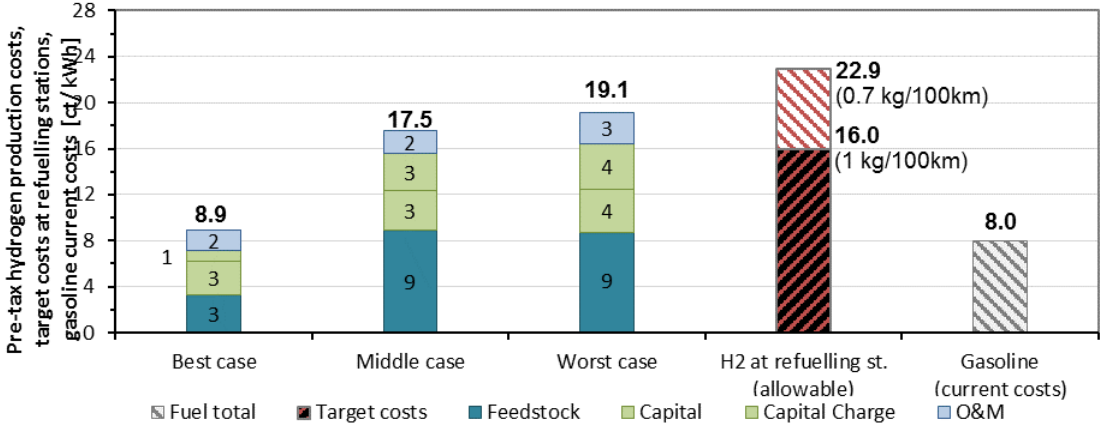
Figure 16. Pre-tax cost analysis for the three cases from Table 2.